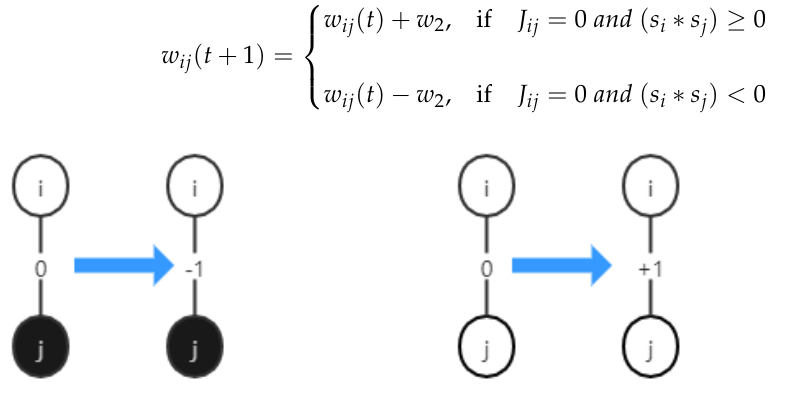
Figure 5. Evolutionary rules of edge =